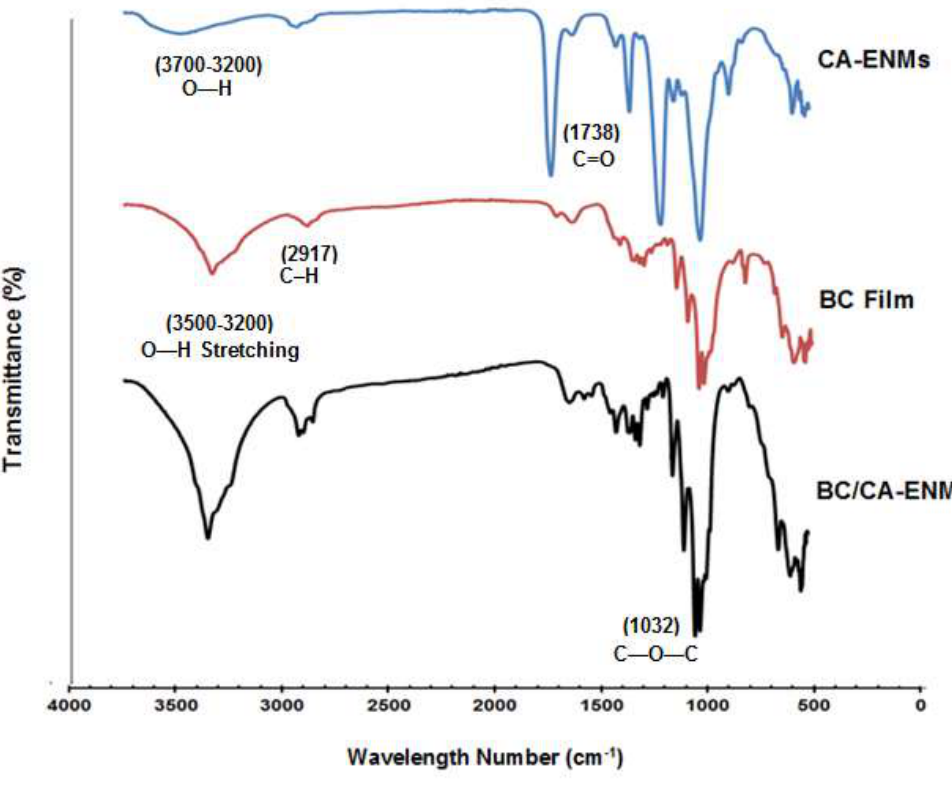
Figure 6. FTIR analysis graphs for BC films, CA-ENMs, and BC/CA-ENM hybrid mat samples.